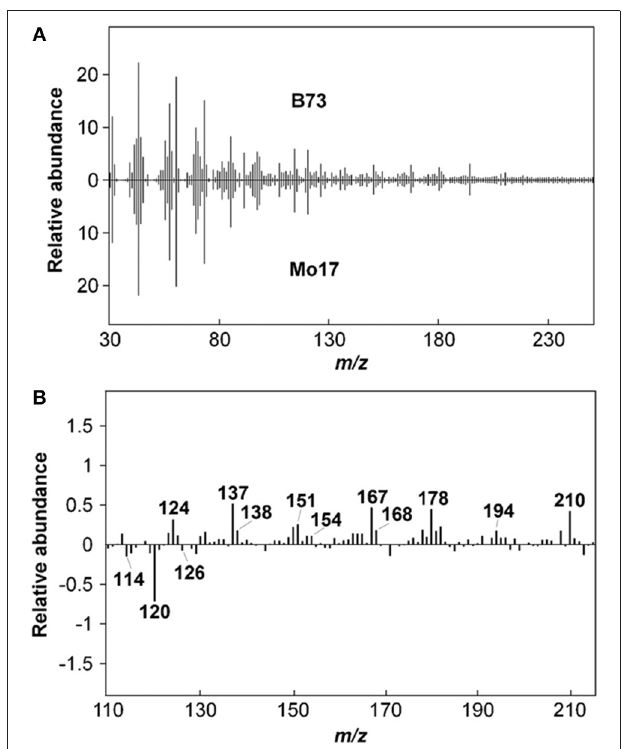
FIGURE 1 | Py-MBMS spectra of maize stems can be used to compare relative abundances of lignin and carbohydrate components. (A) upper and lower spectra of stems from different lines can be subtracted to show differences in certain ions as shown in subtraction spectrum, (B) Reprinted by permission from Penning et al. (2014b), Bioenergy Research: Springer Nature, copyright 2014.